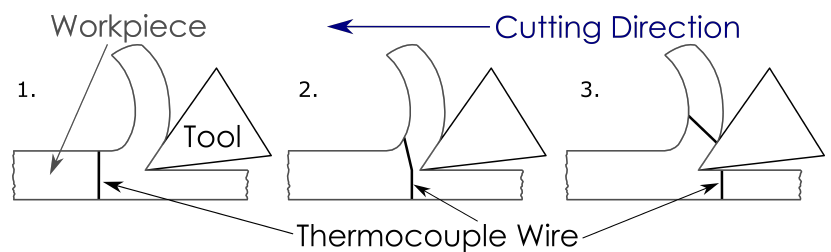
Figure 5. Illustration of single-wire thermocouple machining